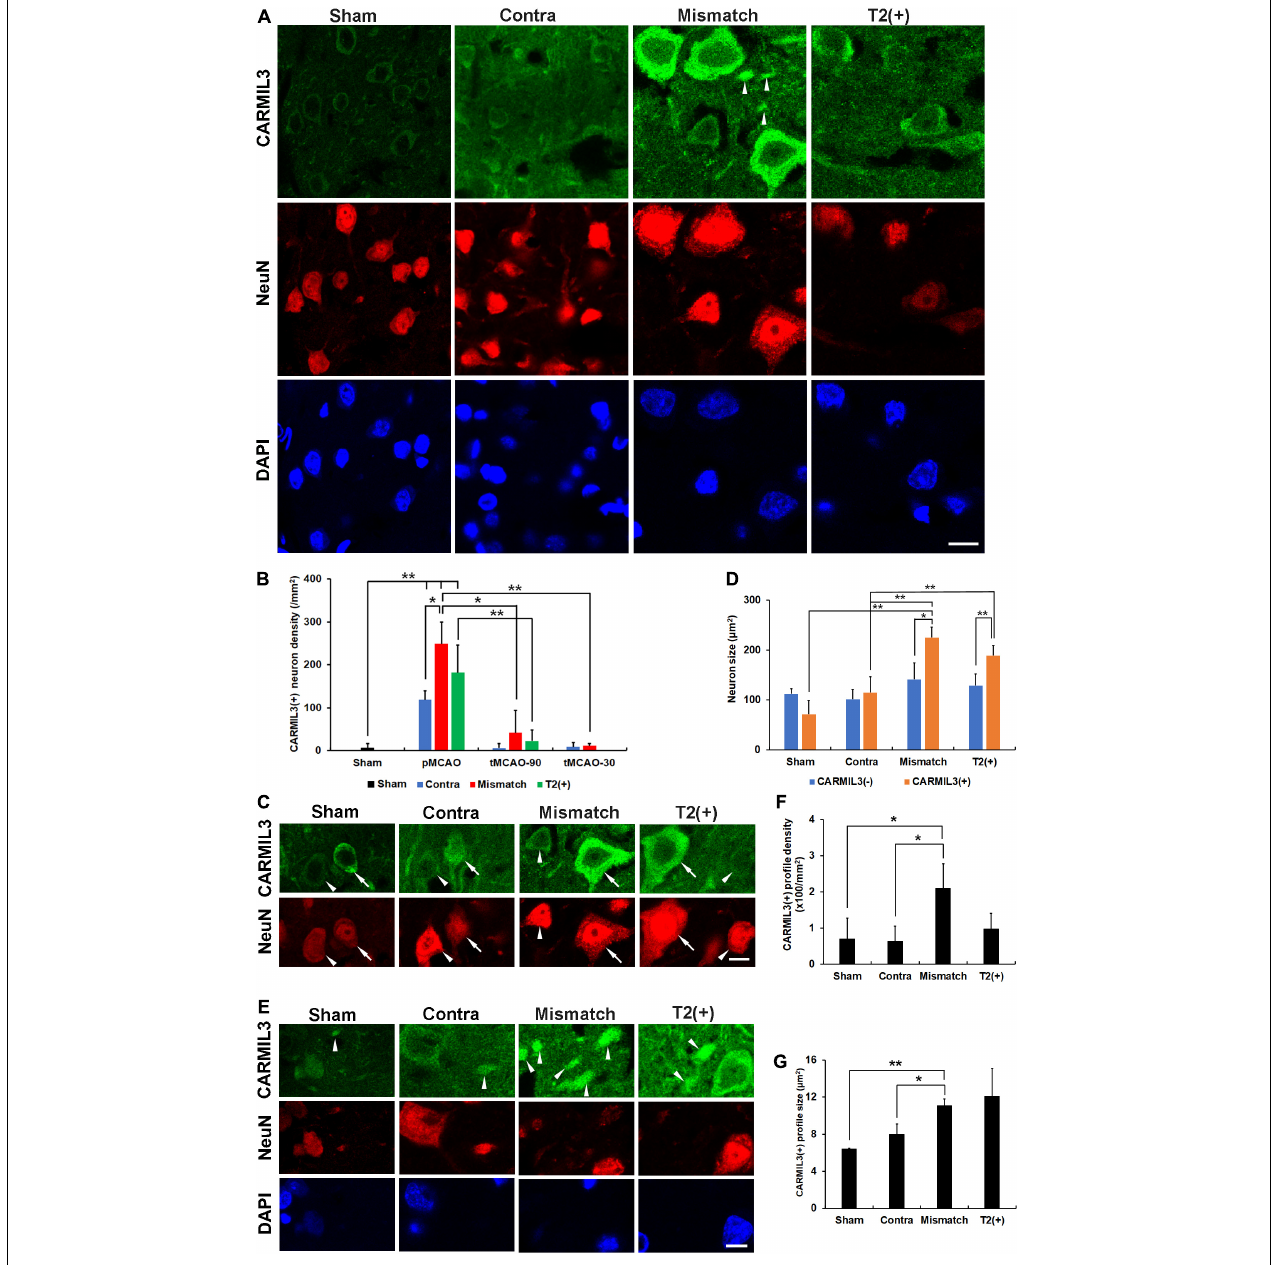
FIGURE 3 | CARMIL3 expression pattern. (A) Expression of CARMIL3 and NeuN in the T2(+), mismatch, contralateral regions of pMCAO groups and sham group. In addition to being expressed in neuronal cytoplasm, CARMIL3 was also expressed in some cell parts without direct connection with neuronal bodies, named CARMIL3(+) profiles (arrowhead). (B) CARMIL3(+) neuron densities at different ischemic cortical regions in pMCAO and tMCAO of rat brains. The expression of CARMIL3 in the T2(+) region after tMCAO-30 was not quantified due to nearly lack of cortical T2(+) area. There was a significant difference in CARMIL3(+) neuron densities among the three regions after pMCAO ( p = 0.028), and all of them were significantly higher than that in the sham group (all p < 0.01). CARMIL3(+) neuron densities in the mismatch regions after pMCAO were higher than those in the contralateral areas ( p = 0.026) and mismatch regions after tMCAO-90 ( p = 0.044) or tMCAO-30 ( p = 0.002). The CARMIL3(+) neuron densities at mismatch regions were significantly different across the three different ischemic durations ( p < 0.0001). The CARMIL3(+) neuron densities at the T2(+) regions after tMCAO-90 were significantly reduced than those after pMCAO ( p = 0.003). (C,D) Representative images of CARMIL3(+) (arrows) and CARMIL3( − ) neurons (arrowheads) at the three regions in pMCAO brains, showing that CARMIL3(+) neurons were bigger than CARMIL3( − ) neurons in the T2(+) and mismatch regions. Moreover, CARMIL3(+) neurons at the T2(+) or mismatch regions were significantly bigger than those in contralateral areas. Two-way ANOVA analysis showed regions ( p = 0.017) and CARMIL3 positivity ( p = 0.018) significantly affected neuron sizes. (E) Representative images of CARMIL3(+) profiles which were more prominent in the mismatch regions. (F,G) The CARMIL3(+) profiles in the mismatch regions were more abundant (F) and larger (G) than those in the contralateral regions or sham group (all p < 0.05). Contra, contralateral. Scale bars = 10 µ m. N = 4 rats in each group. * p < 0.05; ** p <